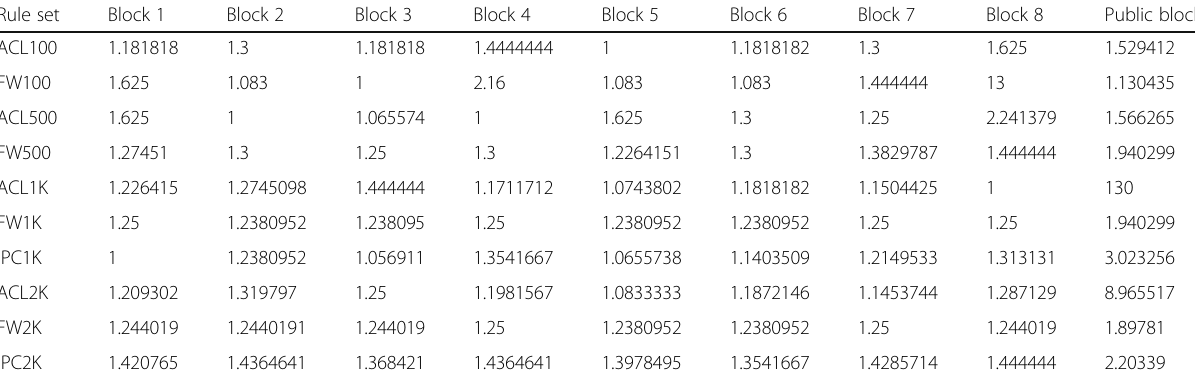
Table 4 Extension ratio in TCAM blocks in the second stage of classification Rule set